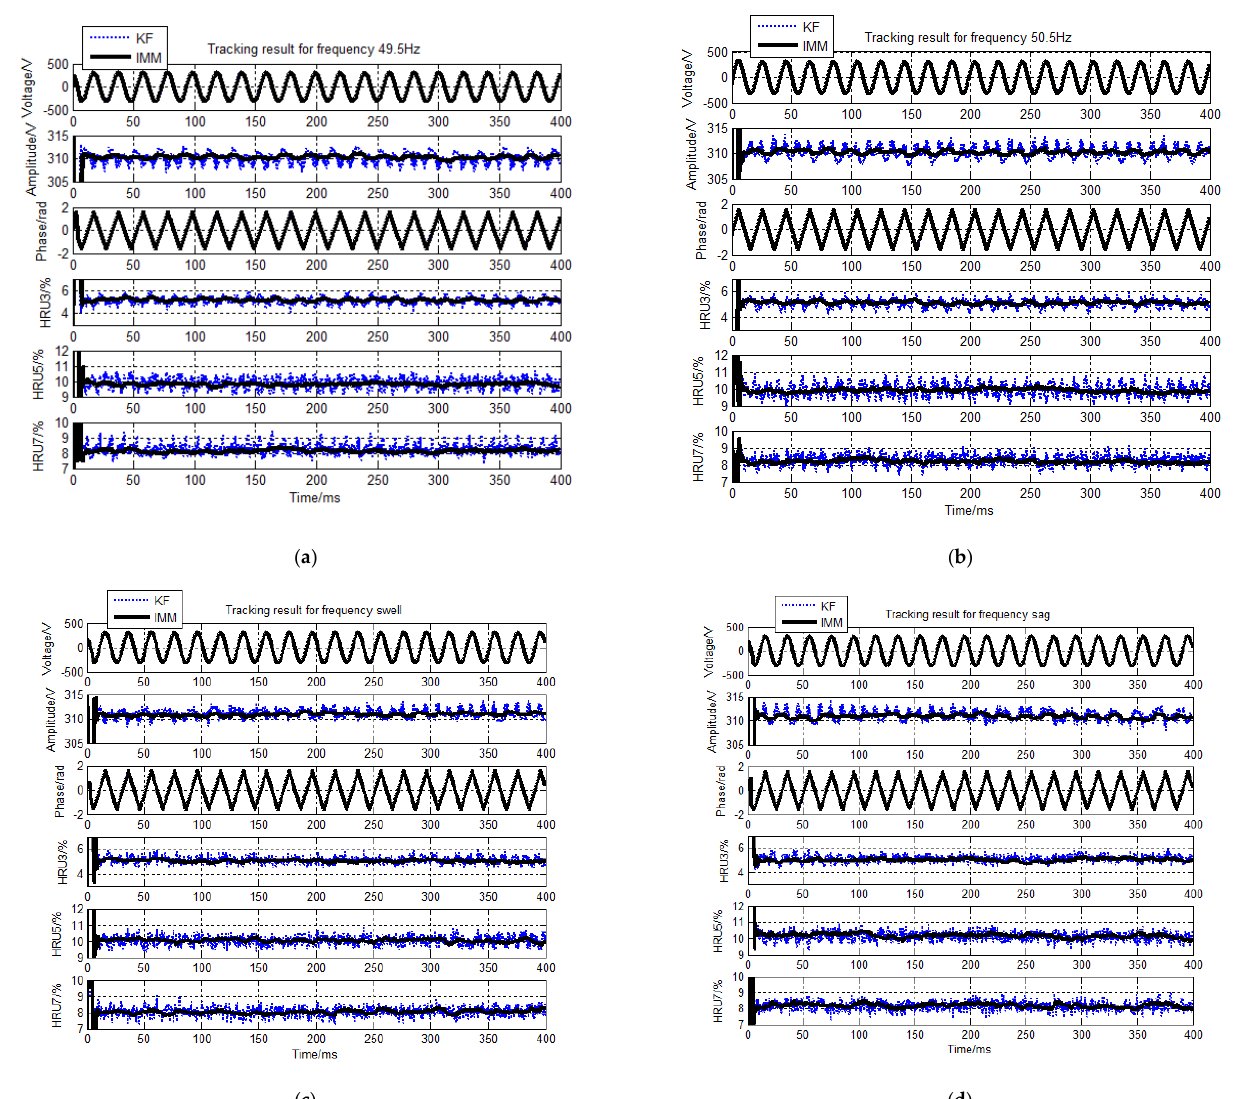
Figure 13. Experiment data for voltage frequency slight fluctuations. ( a ) Frequency 49.98 Hz; ( b ) Frequency 50.02 Hz; ( c ) Frequency swell; ( d ) Frequency sag.